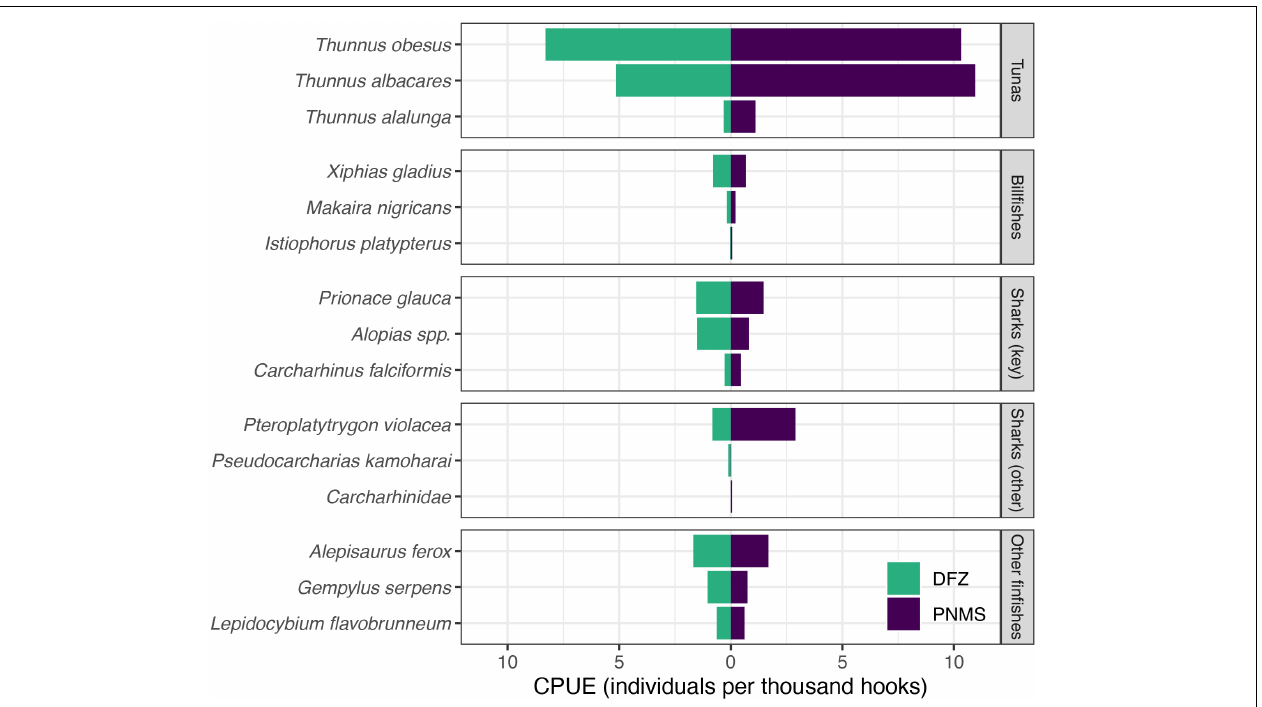
FIGURE 5 | Estimated catch rates catch per unit of effort (CPUE) of selected species caught by the DWF operating in what is now the DFZ (green) and the PNMS (purple). Catch rates were estimated using observer data collected from 2015 to 2019, i.e., the time between the signing into law of the PNMS Act (October 2015) and its full implementation (January 2020). Estimates for additional species are provided in Supplementary Table 4